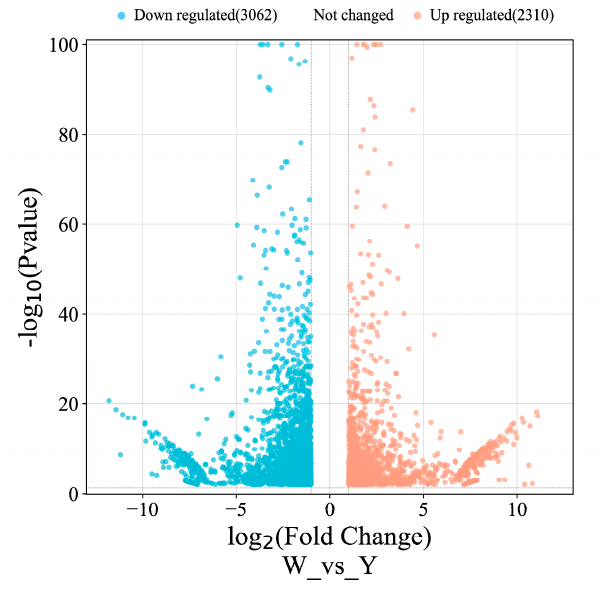
Figure 5. Eukaryotic Orthologous Groups (KOG) annotations of unigenes. 3.5. Screening and Enrichment Analysis of DEGs in Yellow and White Parts of R. liliiflorum Petals 3.5.1. Screening of DEGs By comparing the gene expression levels of the yellow and white parts of the petals of R. liliiflorum , taking |log2fold Change| ≥ 1 and FDR<0.05 as the screening conditions, 5372 DEGs were screened from the comparison of W vs. Y. There were 2310 upregulated unigenes and 3062 downregulated unigenes, and the total number of downregulated uni- genes was higher than the total number of upregulated unigenes (Figure 6).